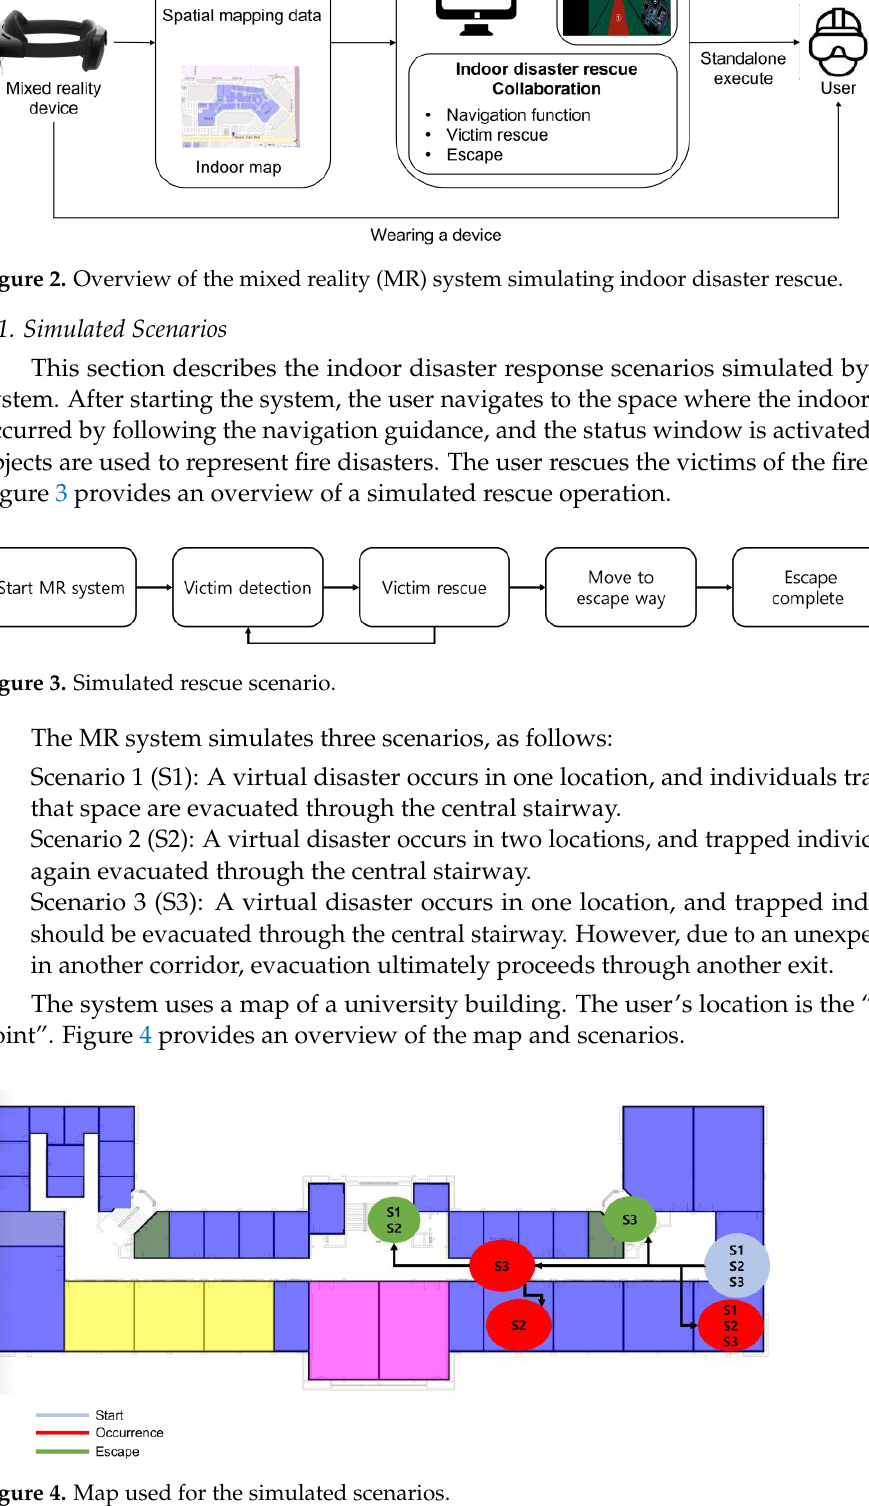
Figure 4. Map used for the simulated scenarios.